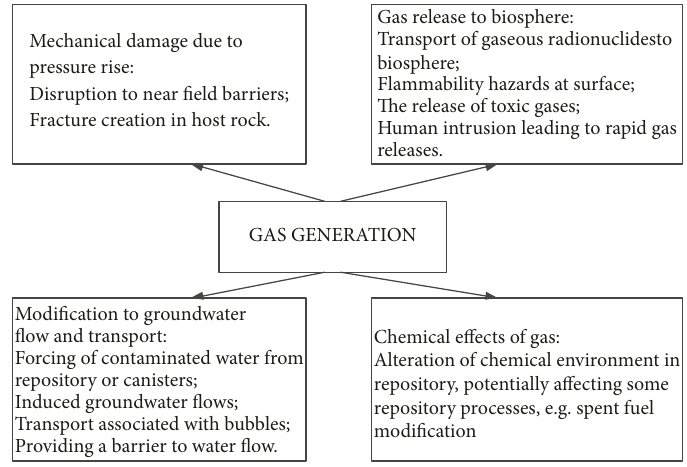
Figure 1: Effects of gas generation in a repository